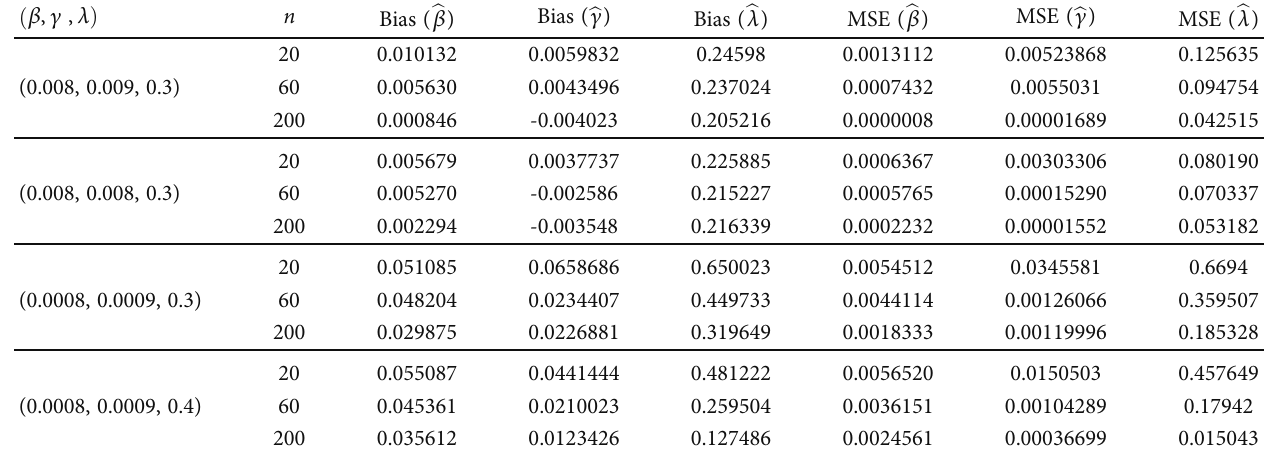
Table 3: True value of parameters with MSE and bias of RFWE ð β , γ , λ Þ .